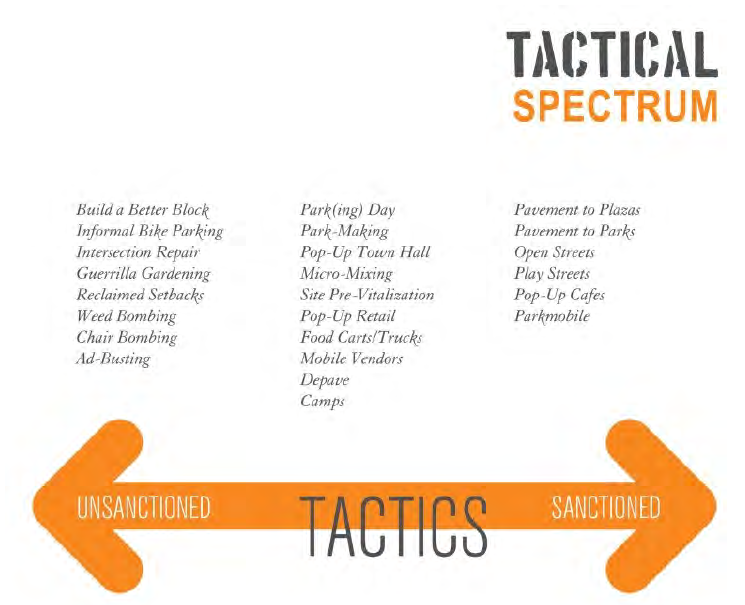
Figure 2. Shows the spectrum of tactical urbanismactivities transformation from the unsanctioned to sanctioned (Lydon, M. &Garcia, A.,